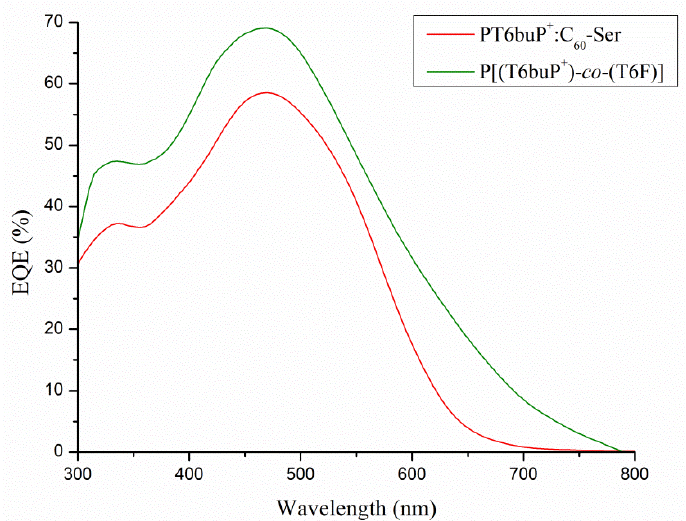
Figure 7. EQE spectra of homo- (PT6buP + ) and co-polymer (P[(T6buP + )- co -(T6F)])